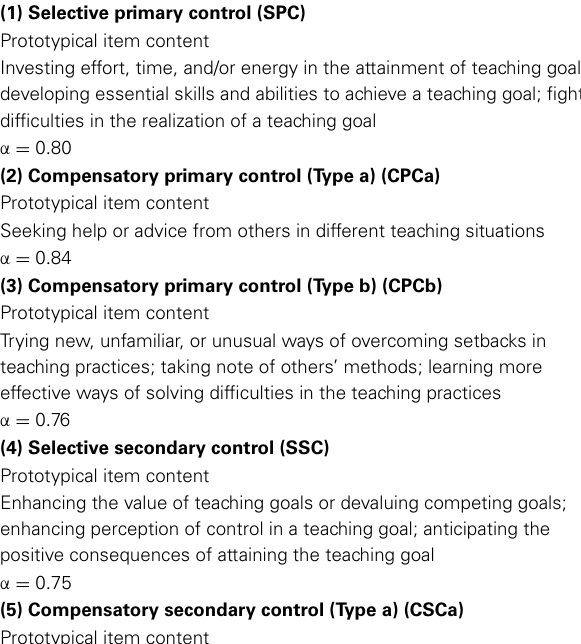
Table 1 | The prototypical item content of the OPST control subscales and optimization